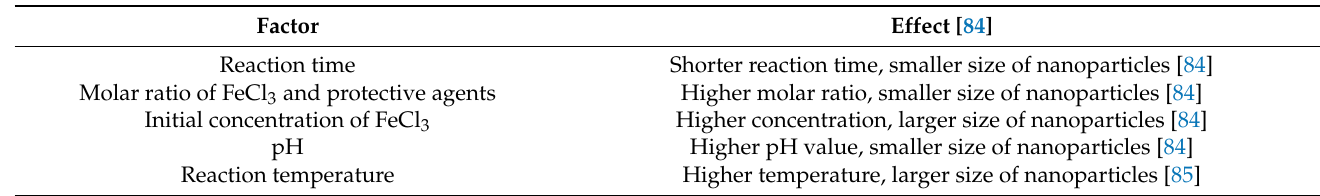
Table 2. Factors affecting particle size and shape of magnetic